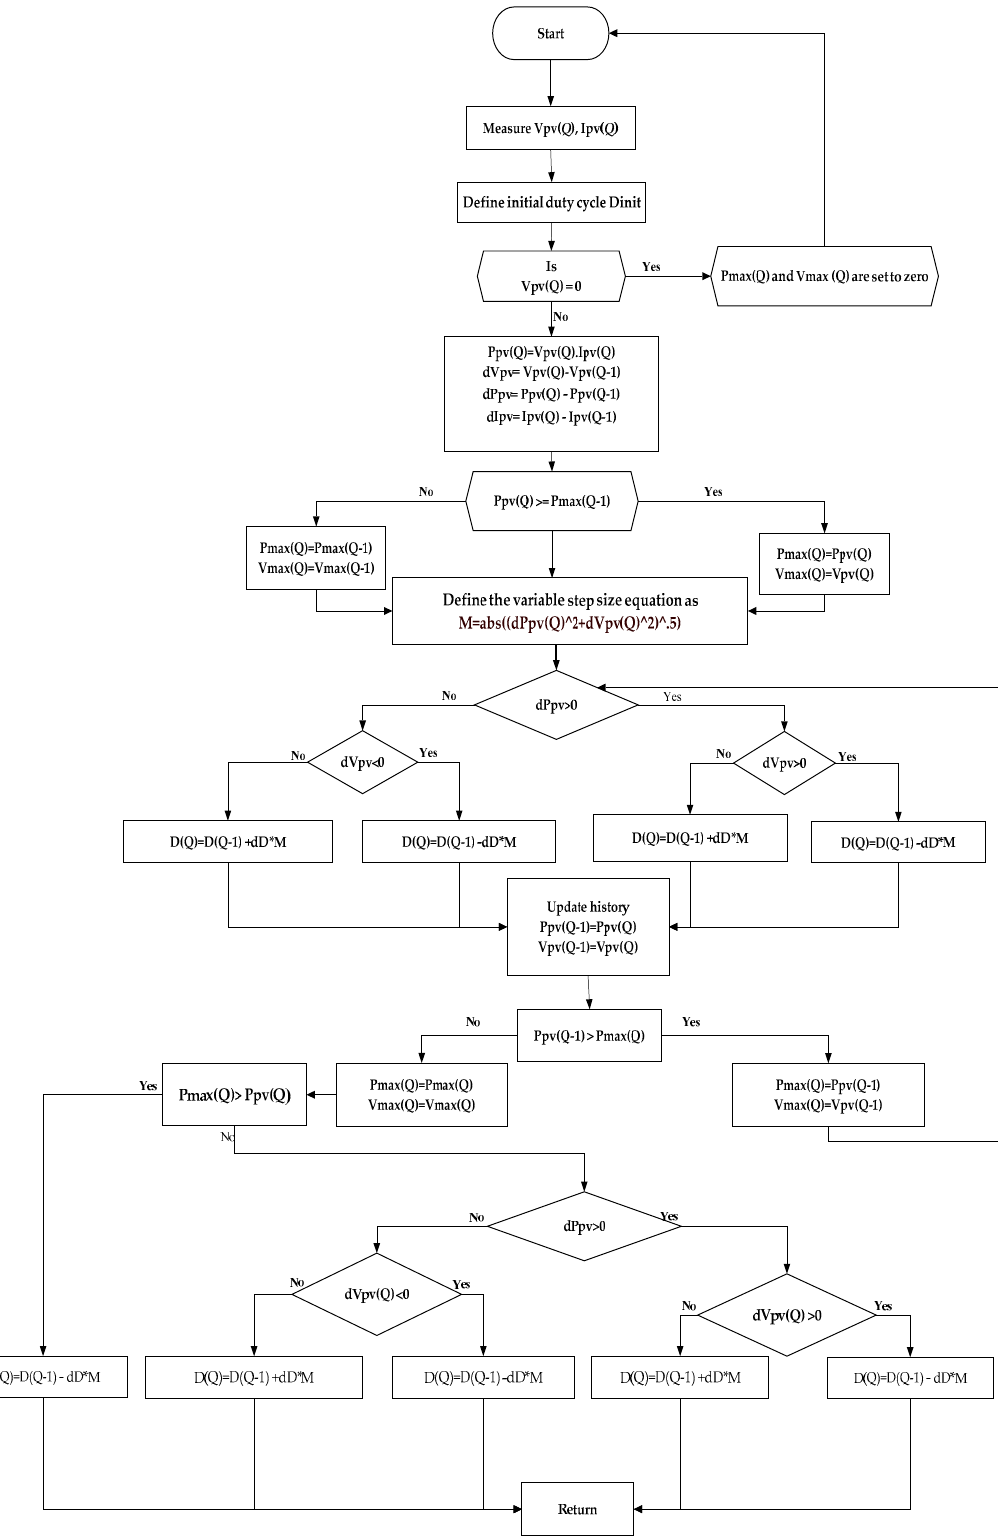
Figure 5. Flowchart of the proposed algorithm.